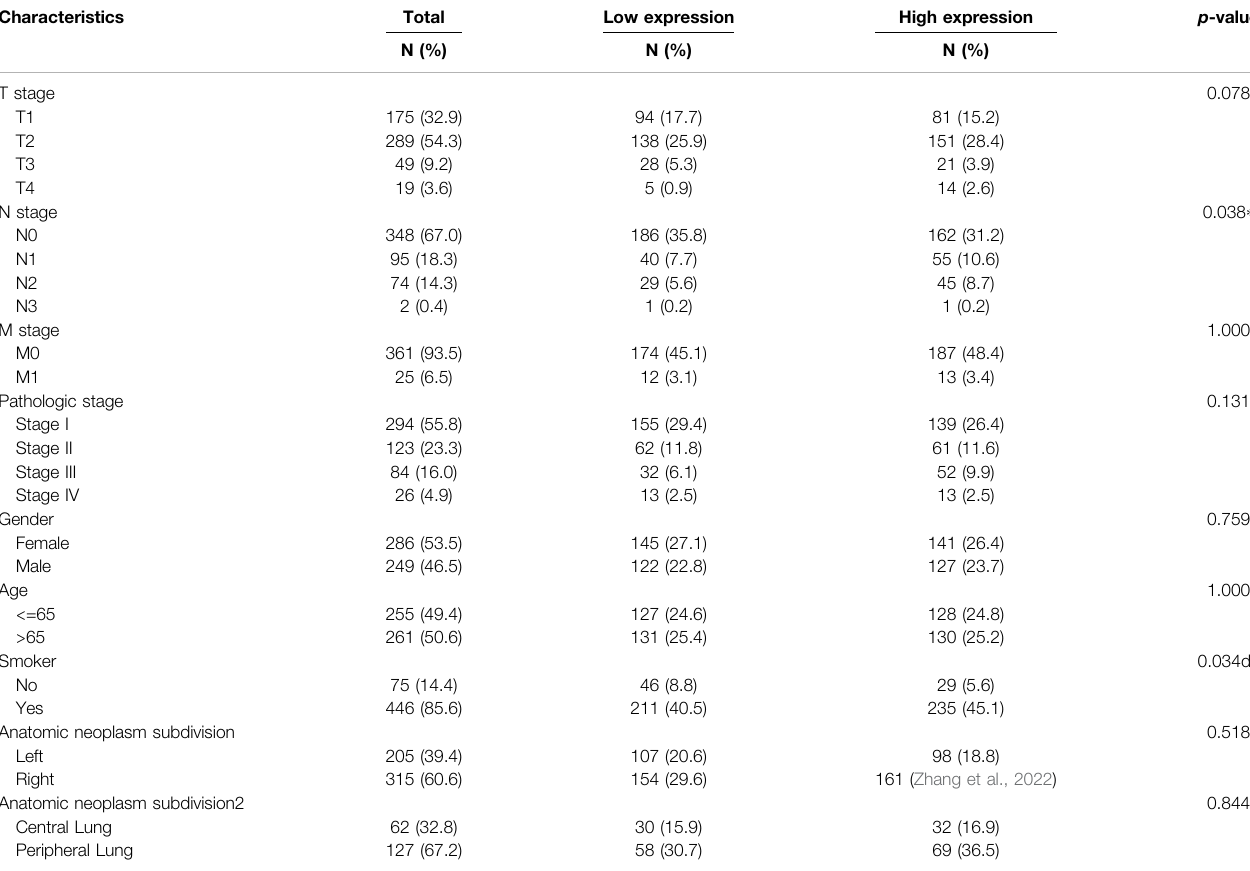
TABLE 1 | The basic characteristics of clinicopathological factors in lung adenocarcinoma patients.